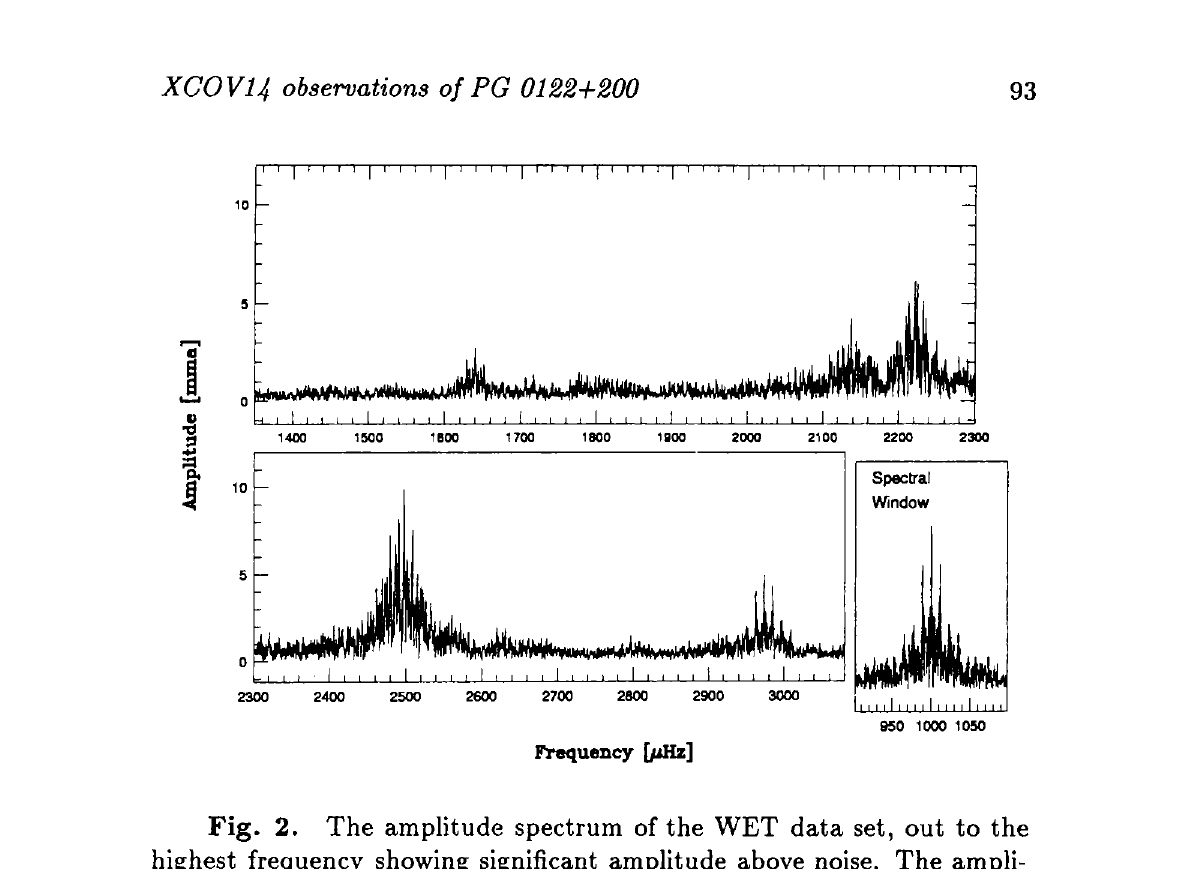
Fig. 2. The amplitude spectrum of the WET data set, out to the highest frequency showing significant amplitude above noise. The ampli- tude is given in units of ma (= A//7). For comparison, the spectral window shows the transform of a single noise-free sinusoid sampled at the same times as the